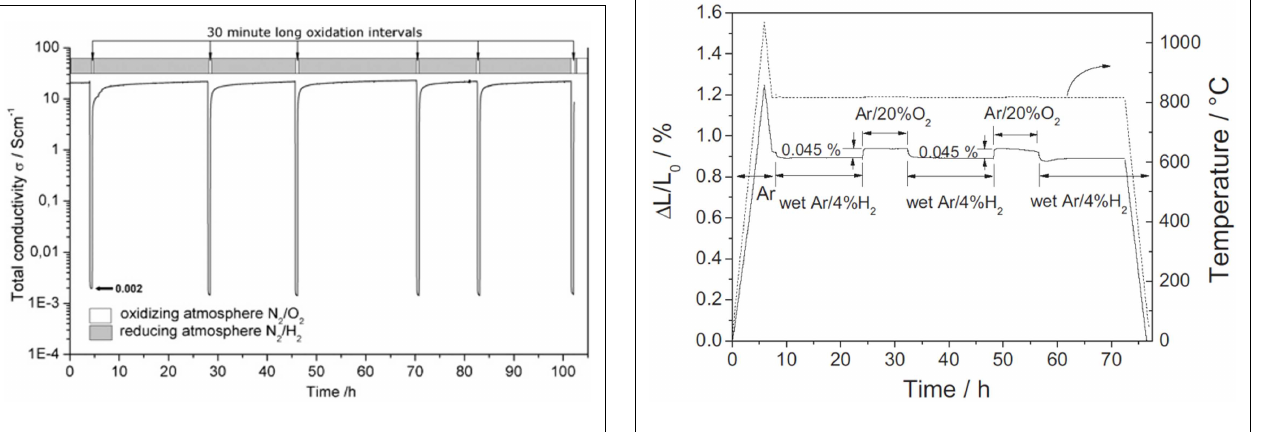
FIGURE 6 | Isothermal redox cycling at 980°C of air sintered La 0.2 Sr 0.704 TiO 3 . Before the measurement, the reduction was lasting 24h at 980°C. Note that each 30min-long oxidation step has led to a complete loss of conductivity (0.002Scm -1 ).The nitrogen flux with 250mlmin -1 was applied for 1min before each oxidation and reduction cycle (Burnat et al., 2012). Reprinted with permission from Elsevier.